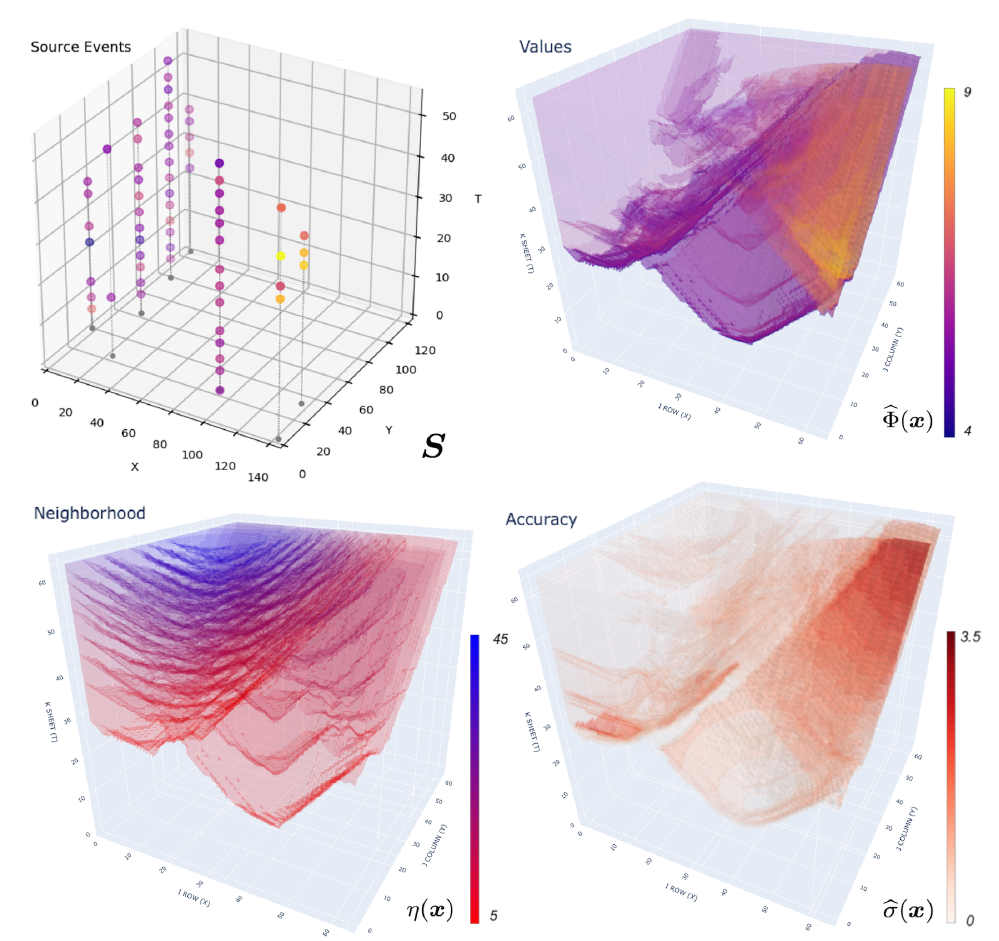
Figure 12. ( Top left ): source events S . ( Top right ): target field values (cid:98) Φ ( x ) . ( Bottom left ): η ( x ) i.e., events in the causal neighborhood S x . ( Bottom right ): accuracy (cid:98) σ ( x ) . The source coordinates are the actual ones, the target coordinates are cell